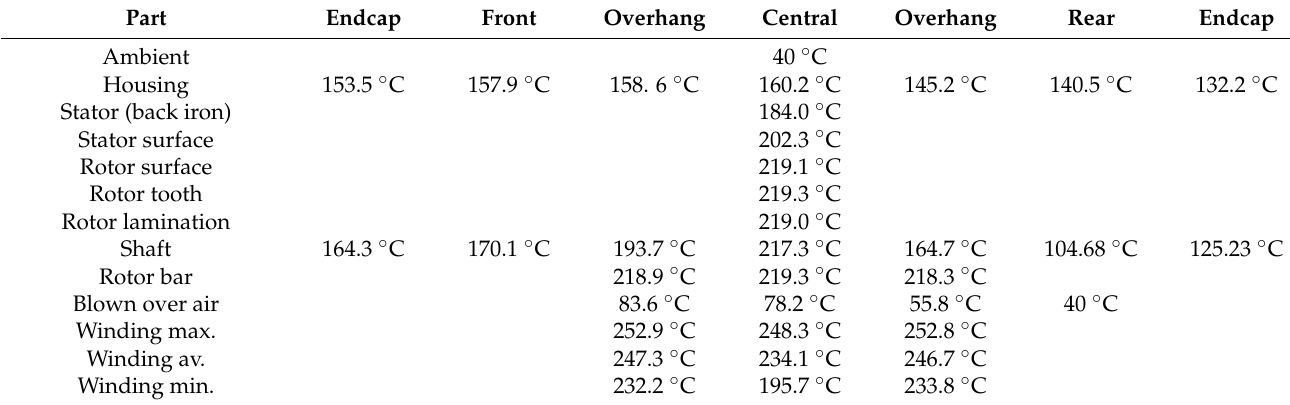
Table 12. Axial temperatures for fan-cooled motor.